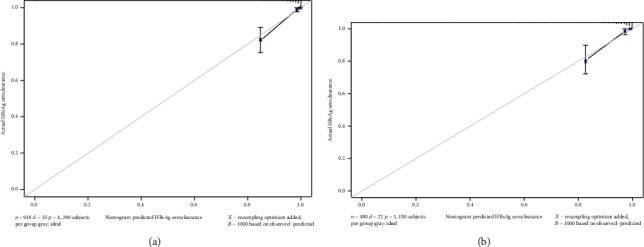
The calibration curves for predicting HBsAg seroclearance for the training cohort (a) and the validation cohort (b). Nomogram-predicted probability of HBsAg seroclearance is plotted on the x-axis; actual HBsAg seroclearance is plotted on the y-axis.